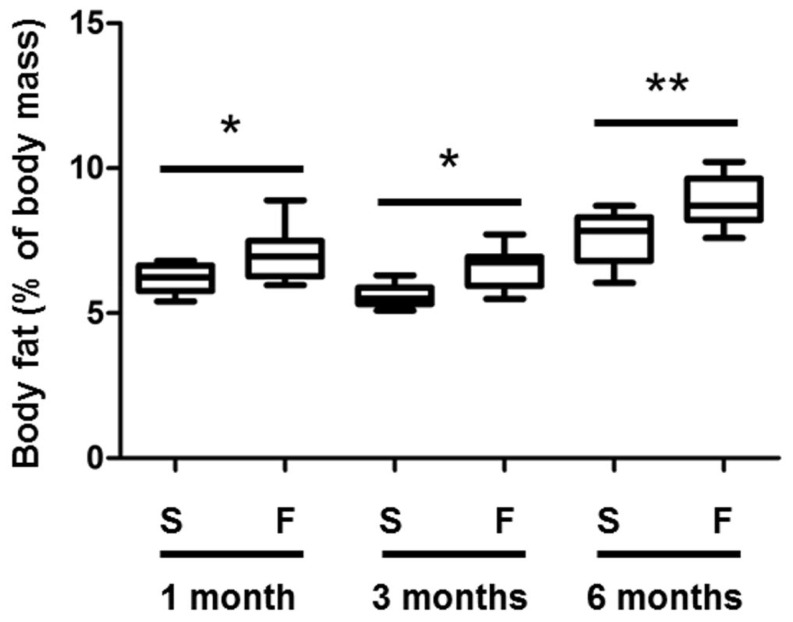
Body fat is increased in rats fed with a 60%-rich fructose diet.Body fat (expressed as % of body mass) was quantified by EchoMRI in the rat after 1, 3, and 6 months of feeding with either the standard (S) or 60%-rich fructose (F) diet. * and ** statistically different at p≤0.05 and 0.01, respectively (Mann & Whitney test). The bottom and top of the box are the first and third quartiles, and the band inside the box is the median. The ends of the whiskers are 1 standard deviation above and below the mean of the data (n = 8 rats per group).